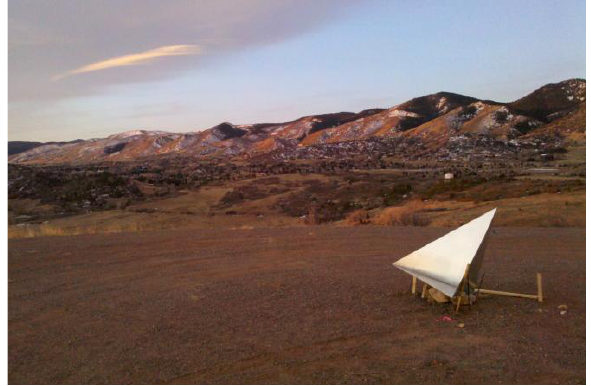
Figure 6. Ideal radar reflector pointed at the